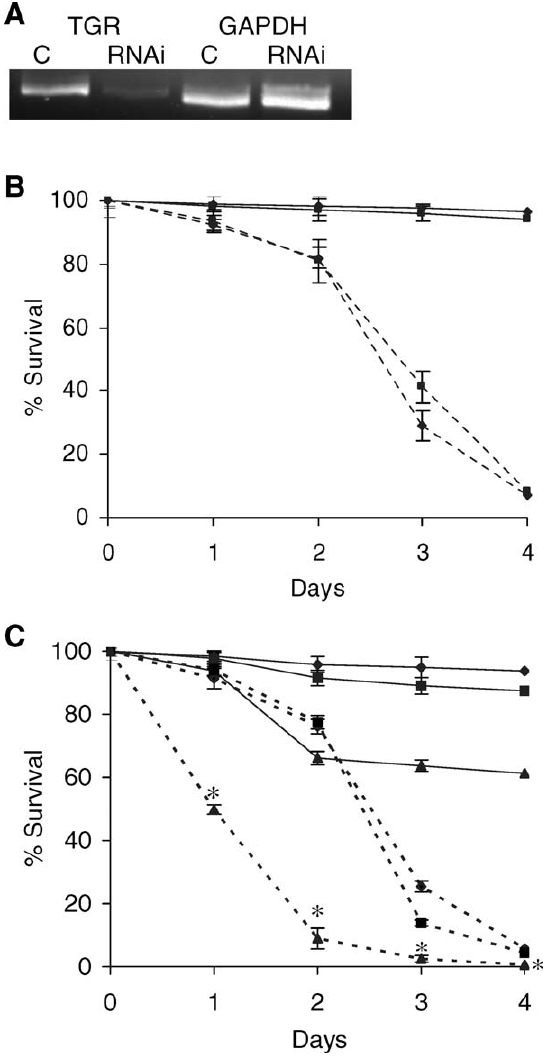
Figure 7. Survival of Schistosomula after RNAi Silencing of TGR Expression (A) Qualitative measure of TGR transcripts by reverse transcription PCR. The abundance of TGR mRNA was greatly reduced by dsRNA treatment while the control gene GAPDH was unaffected. (B) Parasites were cultured in the presence of double-stranded TGR RNA (dashed lines) or of double-stranded irrelevant RNA (solid lines) in 20% O 2 ( ¤ ) or 0% O 2 ( & ). A 500-nucleotide fragment (bp 1364–1866) of S. mansoni TGR cloned into PCRII-TOPO vector was used to transcribe TGR dsRNA. Irrelevant, nonschistosome dsRNA used for negative controls was synthesized from the PCRII-TOPO vector using T7 and SP6 RNA polymerases. (C) Combination of RNAi and drug treatments. Solid lines are irrelevant dsRNA treatments and dashed lines are dsTGR treatments; no additions ( ¤ ), 2 l M praziquantel ( & ) and 2 l M AF ( m ). At each time point, data comparing the combination treatment (2 l M AF þ TGR dsRNA) to either 2 l M AF or TGR dsRNA alone were statistically significant (* p , 0.004). In each experiment for each time point at least 1,500 parasites were scored as alive or dead (three replicates of 500 parasites). The error bars represent the standard deviations of three independent